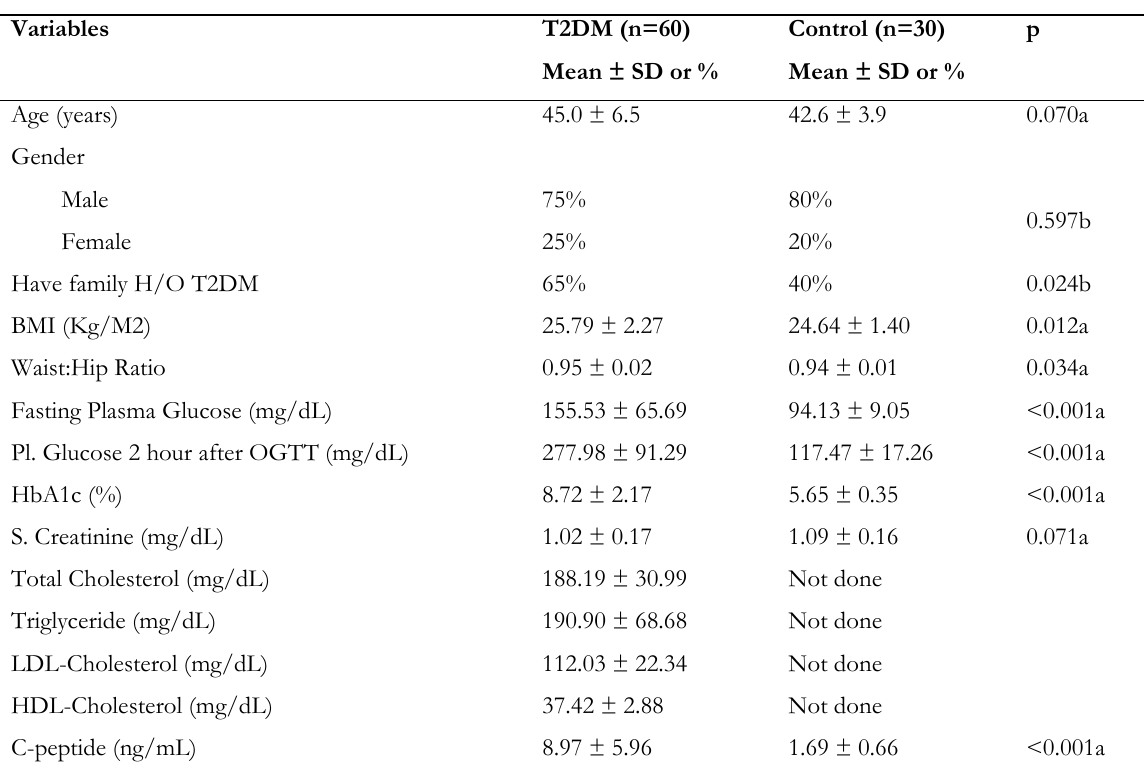
Table 1. Demographic, clinical and biochemical characteristics of the study participants